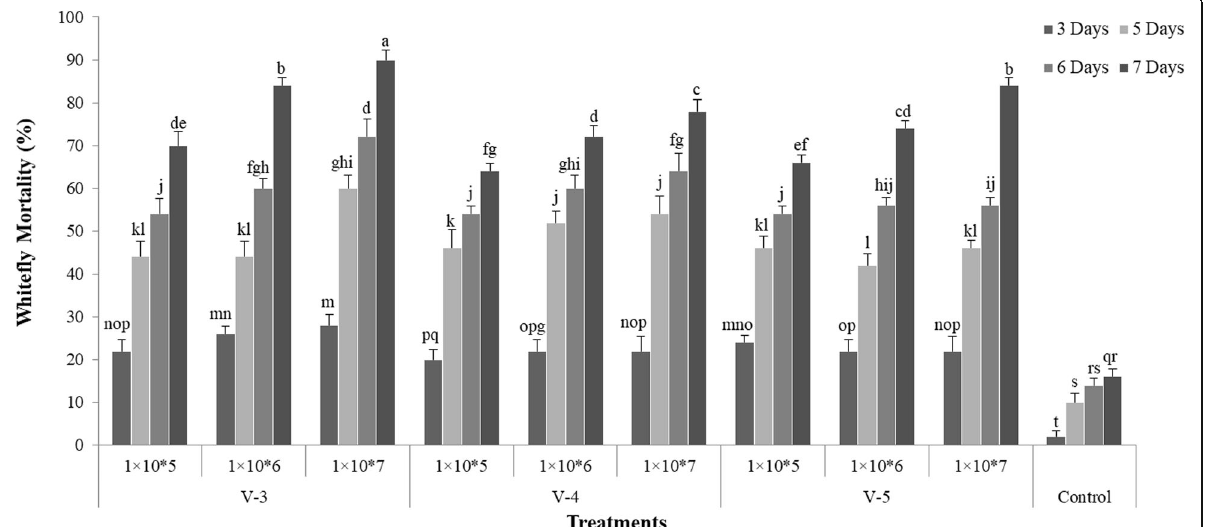
Fig. 1 Mean mortality (%) of Bemisia tabaci noted at different time intervals (3rd, 5th, 6th, and 7th) for conidial bioassays executed with different strains of Lecanicillium lecanii (V-3, V-4, and V-5) at three conidial concentrations (i.e., 1 × 10 5 , 1 × 10 6 , and 1 × 10 7 conidia ml − 1 ) of each fungal strain and one control. The columns show mean percent mortality ± SE ( n = 5). Treatment columns bearing different alphabets are significantly different from other treatments (LSD test at p = 0.05). See Table 1